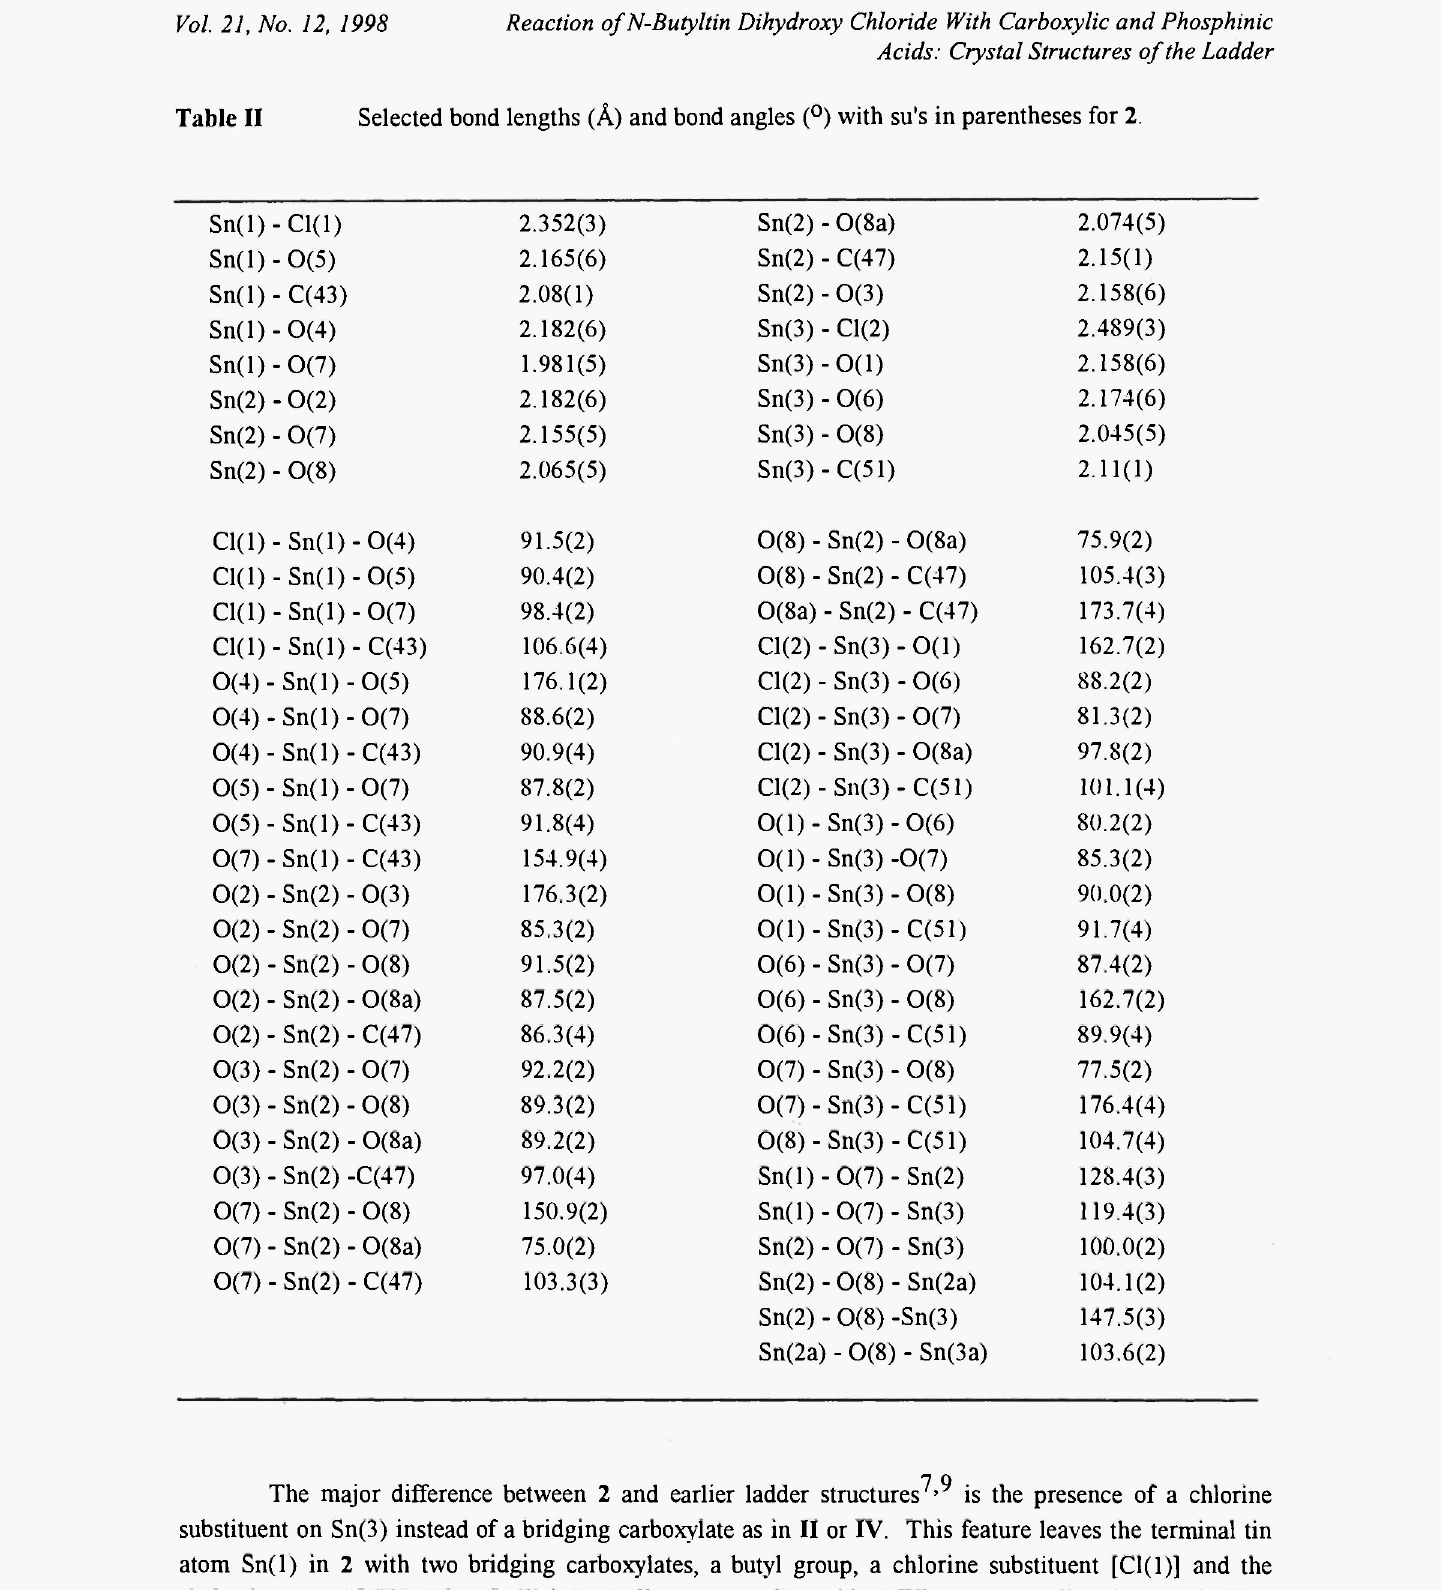
The major difference between 2 and earlier ladder structures ' is the presence of a chlorine substituent on Sn(3) instead of a bridging carboxylate as in II or IV. This feature leaves the terminal tin atom Sn(l) in 2 with two bridging carboxylates, a butyl group, a chlorine substituent [CI(1>] and the skeletal oxygen [0(7)]. Thus Sn(l) is basically pentacoordinated in 2 [The corresponding tin atom in II or IVa is heptacoordinated and that in IVb is